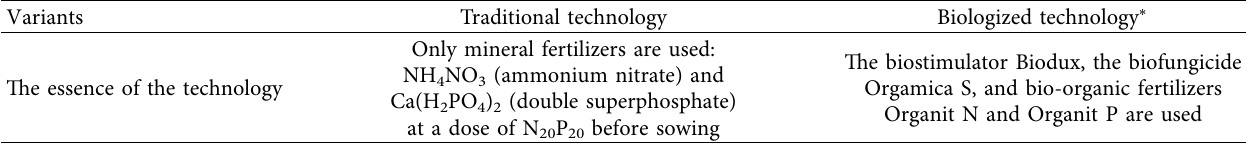
Table 2: A scheme of the field